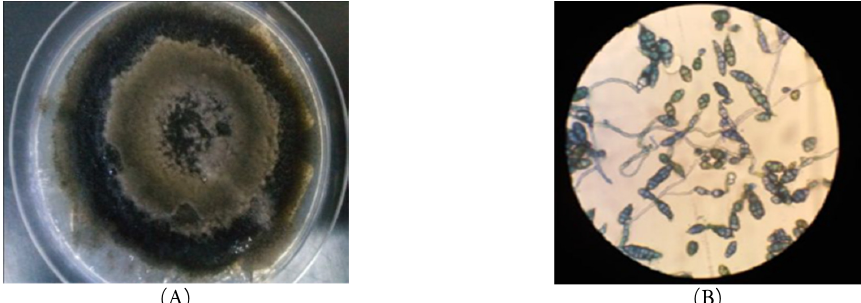
Figure 5. Result of macro and microscopic observation of pathogenic isolates Tom1 and Tom3; (A) macroscopic characterization; (B) microscopic